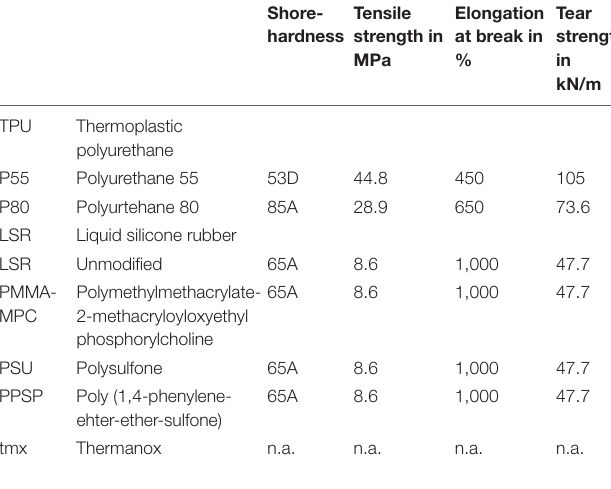
TABLE 1 | Material specification and mechanical